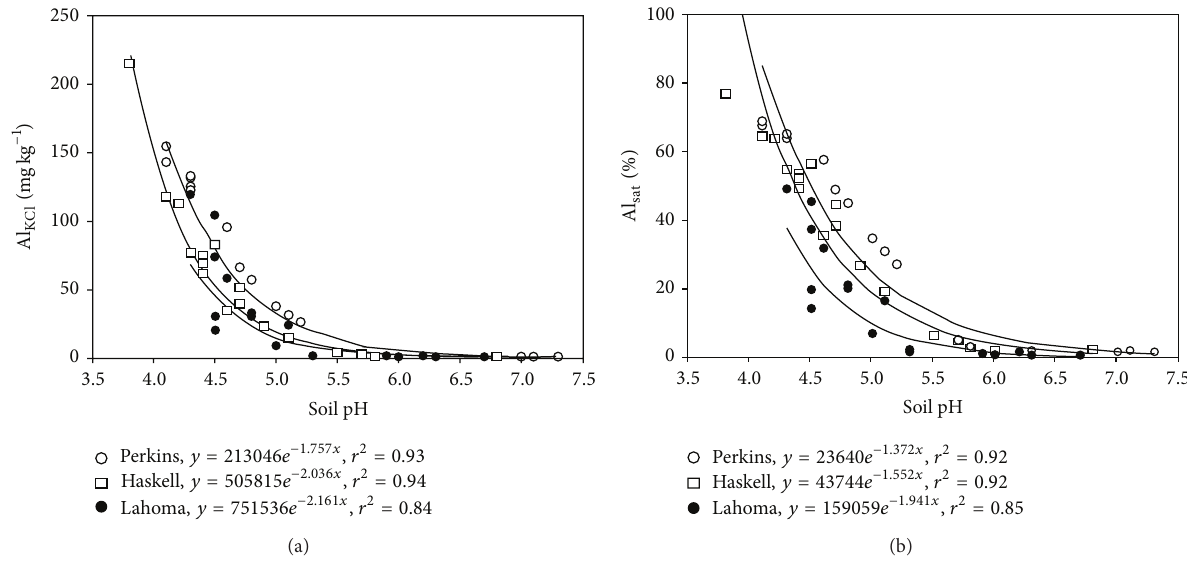
Figure 3: Potassium-chloride-extractable aluminum concentration (mg kg −1 ) and aluminum saturation (%) in the soil as the functions of soil pH from a 15cm composite soil sample for each treatment at Perkins, Haskell, and Lahoma, Oklahoma (2010).